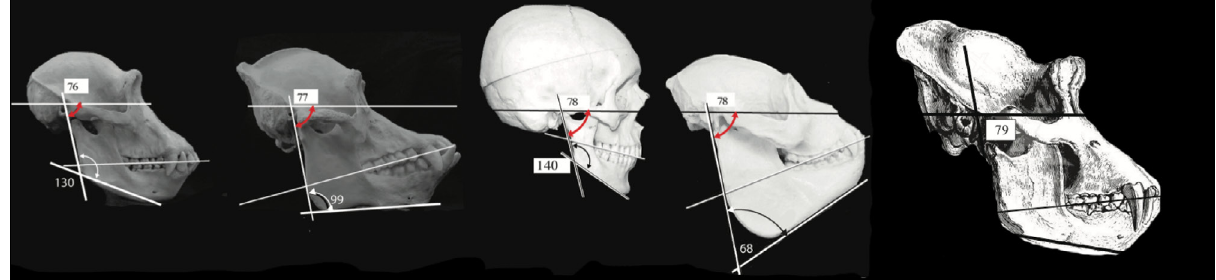
Figure 7: The angle, in degrees, between the posterior margin of the mandibular ramus and the Frankfurt horizontal (which coincides more or less with the zygomatic arch), demonstrating the rationale for using a fixed orientation of the mandibular ramus. From left to right (not shown to scale): chimpanzee, orangutan, Homo sapiens , howler monkey and gorilla. Note the similar angle, at 78°, in even the most extreme cases – H. sapiens and the howler monkey. In contrast, note the variation in the orientation of the occlusal plane and the inferior margin of the mandibular body.